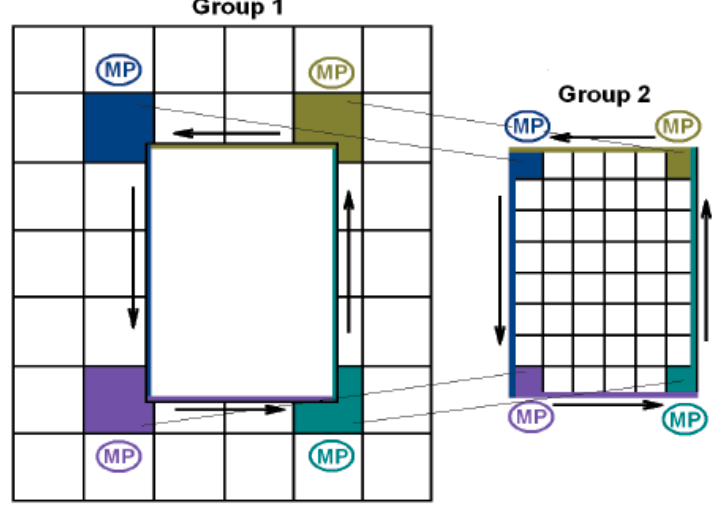
Figure 3. Processor Units for the coarse (left) and fine (right) grids.